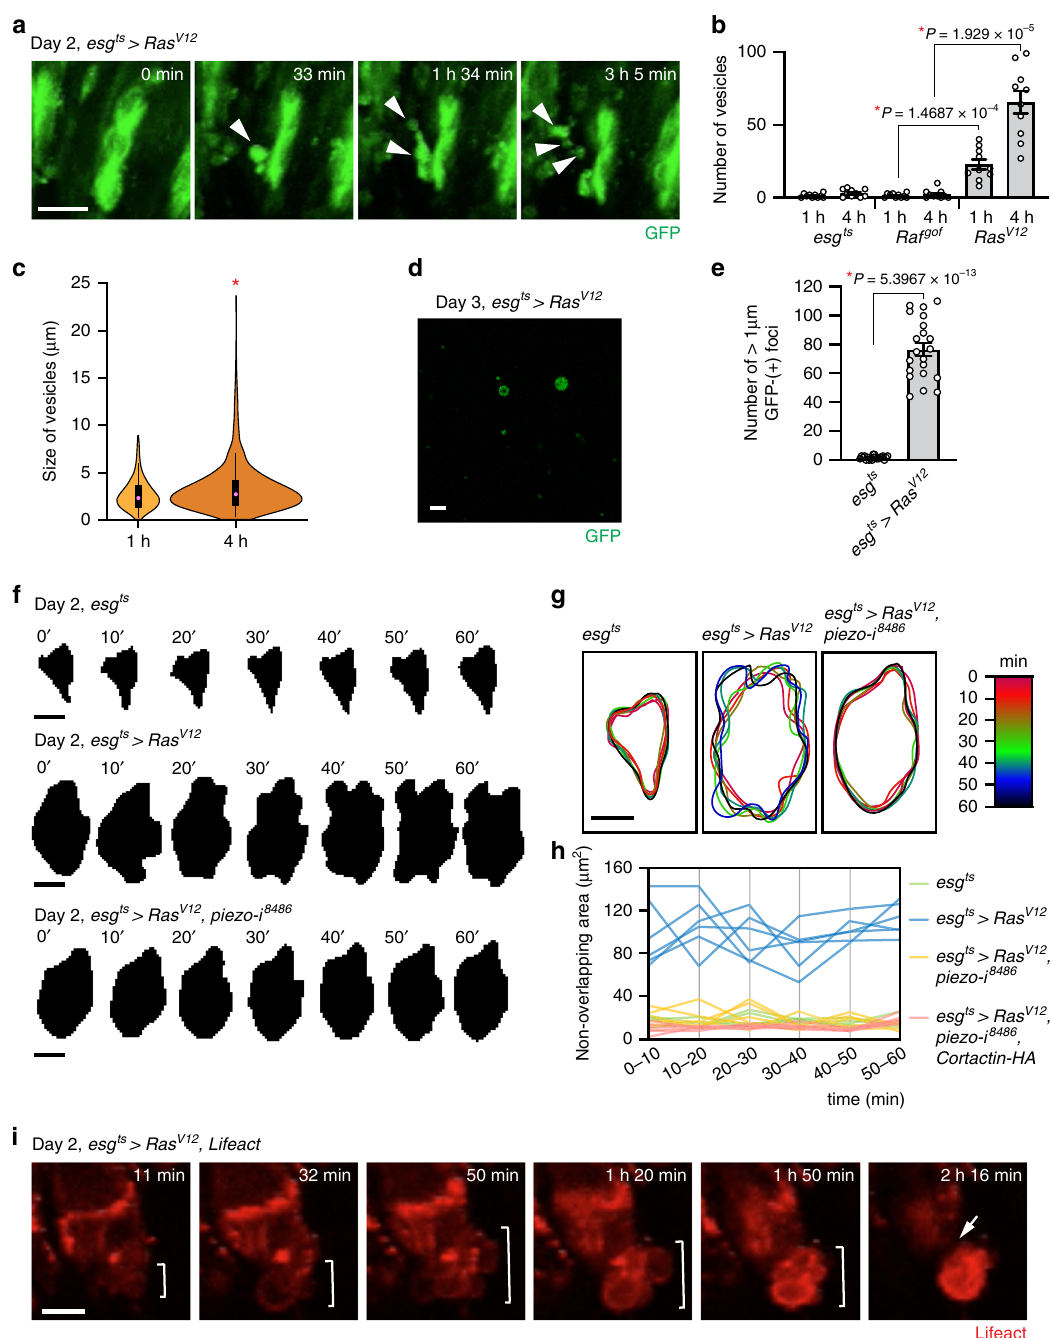
Fig. 4 Ras V12 cells generate blebs and ELEVs and disseminate by extensive blebbing. a Still shots from ex vivo live imaging of esg ts > Ras V12 midgut. Arrowheads indicate blebs and ELEVs. Scale bar, 10 µ m. b , c Quanti fi cation of ELEVs generated from dissected midgut. Transgenes were induced for 2 days with esg ts . Number and size of ELEVs produced from dissected midgut were measured at 1 and 4 h post incubation in ex vivo live-imaging media. N = 10 biological replicates for each genotype. b Number of ELEVs. c Size of ELEVs. Circles show the medians (1 h, 3.0928 µ m; 4 h, 3.6199 µ m); box limits indicate the 25th and 75th percentiles; whiskers extend 1.5 times the interquartile range from the 25th and 75th percentiles. d Representative image of circulating ELEVs. Scale bar, 10 µ m. e Quanti fi cation of GFP + particles in hemolymph. Green particles bigger than 1 µ m were counted. N = 21 from three independent experiments for each genotype. f – h Outline tracing of representative cells in esg ts , esg ts > Ras V12 , and esg ts > Ras V12 , piezo RNAi 8486 midguts. f Time series of cell boundary masks. The representative cells were traced for an hour from ex vivo live-imaging videos. Masks of the cells were generated every 10 min. Scale bars, 10 µ m. g Overlay of cell outlines. Time series of the cell silhouettes were color-coded and overlaid. Scale bar, 10 µ m. h Deviation of cell boundary. Non-overlapping area of two cell silhouettes acquired at consecutive time points ( n ′ and n + 10 ′ , n = 0 ′ , 10 ′ , 20 ′ , 30 ′ , 40 ′ , 50 ′ ) is measured. N = 6 for each genotype. i Still shots from ex vivo live imaging of esg ts > Ras V12 midgut. Lifeact is expressed to visualize fi lamentous actin (red). Brackets indicate blebbing. Arrow points out the detachment of the blebbing cell from the midgut epithelium. Scale bar, 10 µ m. In ( b , e ), mean ± SEMs are shown with individual data points. Data were analyzed by two-tailed unpaired Student ’ s t -test. Asterisks indicate statistical signi fi cance (* P < 0.01), and P values are indicated in